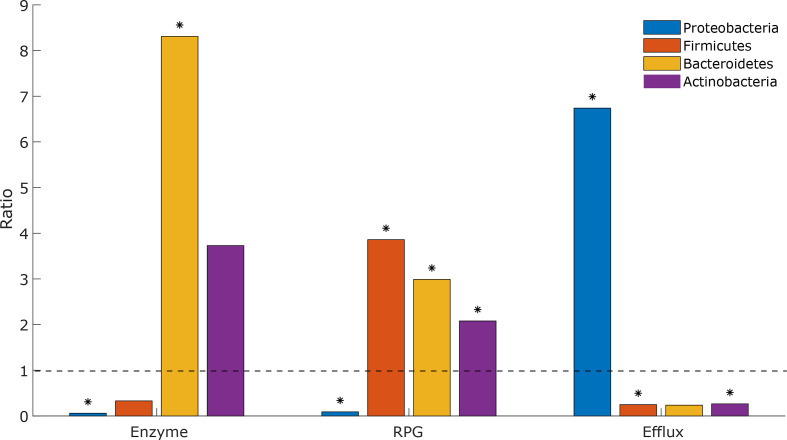
Phylum analysis of genomes carrying tetracycline resistance genes. The analysis was based on genomes present in NCBI RefSeq and HMP genomic databases. The significance of the ratios was assessed using Fisher’s exact test and results with P <0.001 are marked by asterisks. RPG, Ribosomal protection genes.